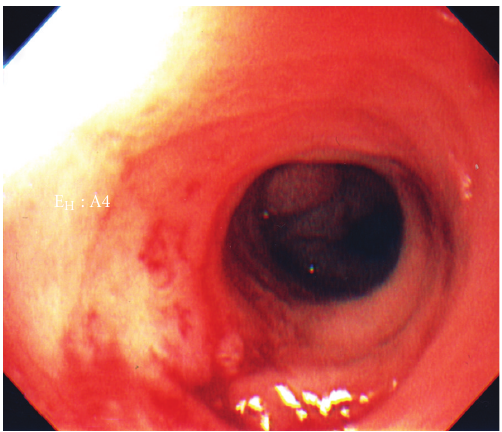
Figure 3: After-dilation, the pyloric channel was now patent. Endo- scopic gastroduodenoscope passed easily up to the second part of the